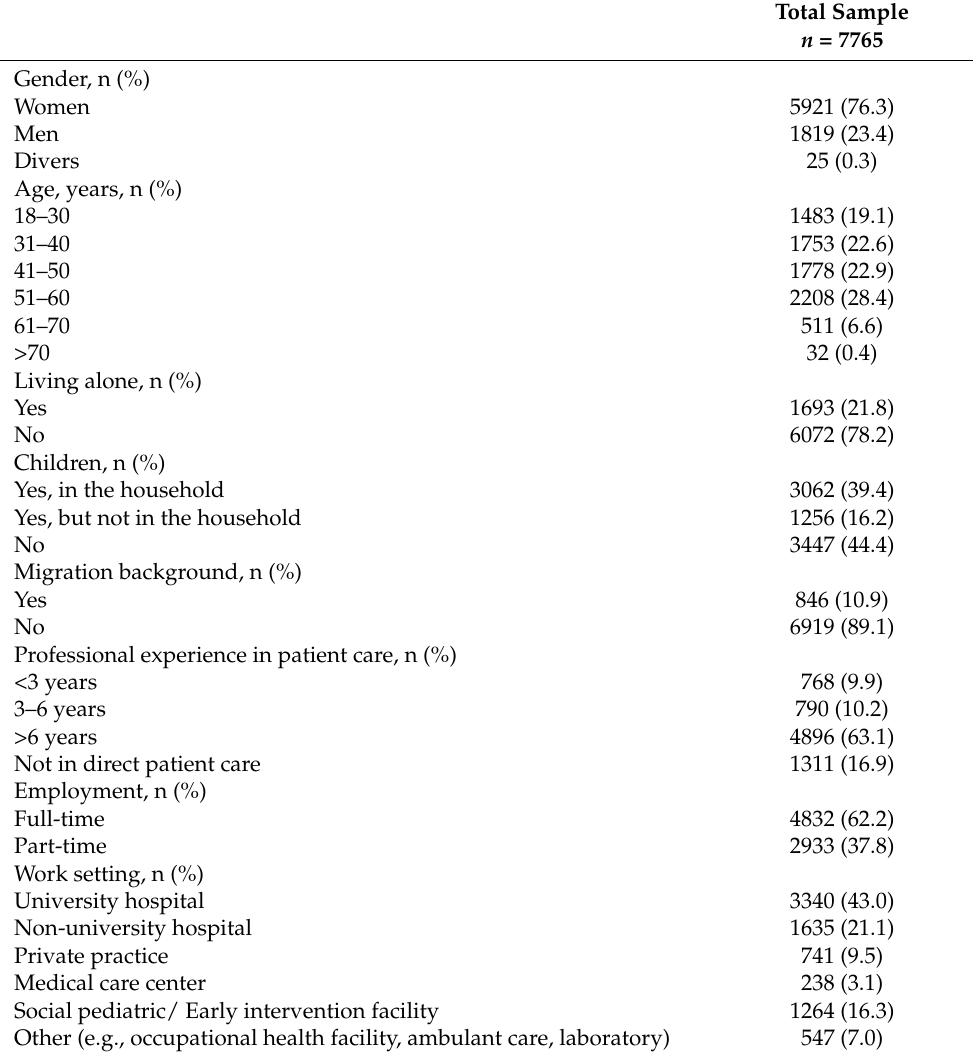
Table 1. Socio-demographic and occupational characteristics of the study sample.